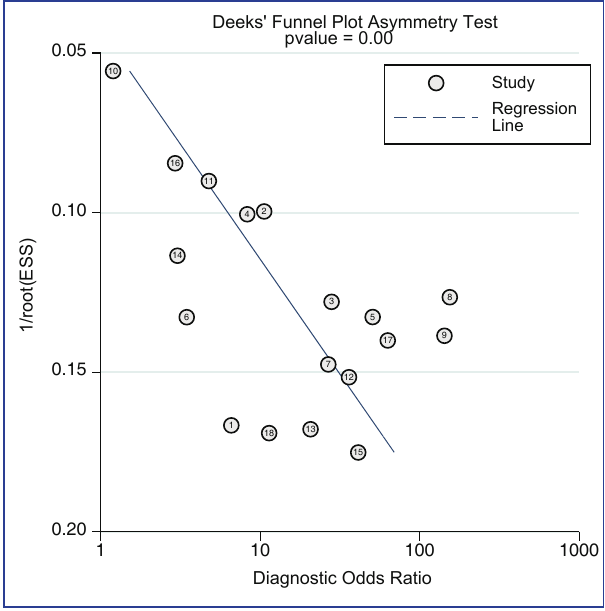
Deeks' Funnel Plot Asymmetry Test pvalue =